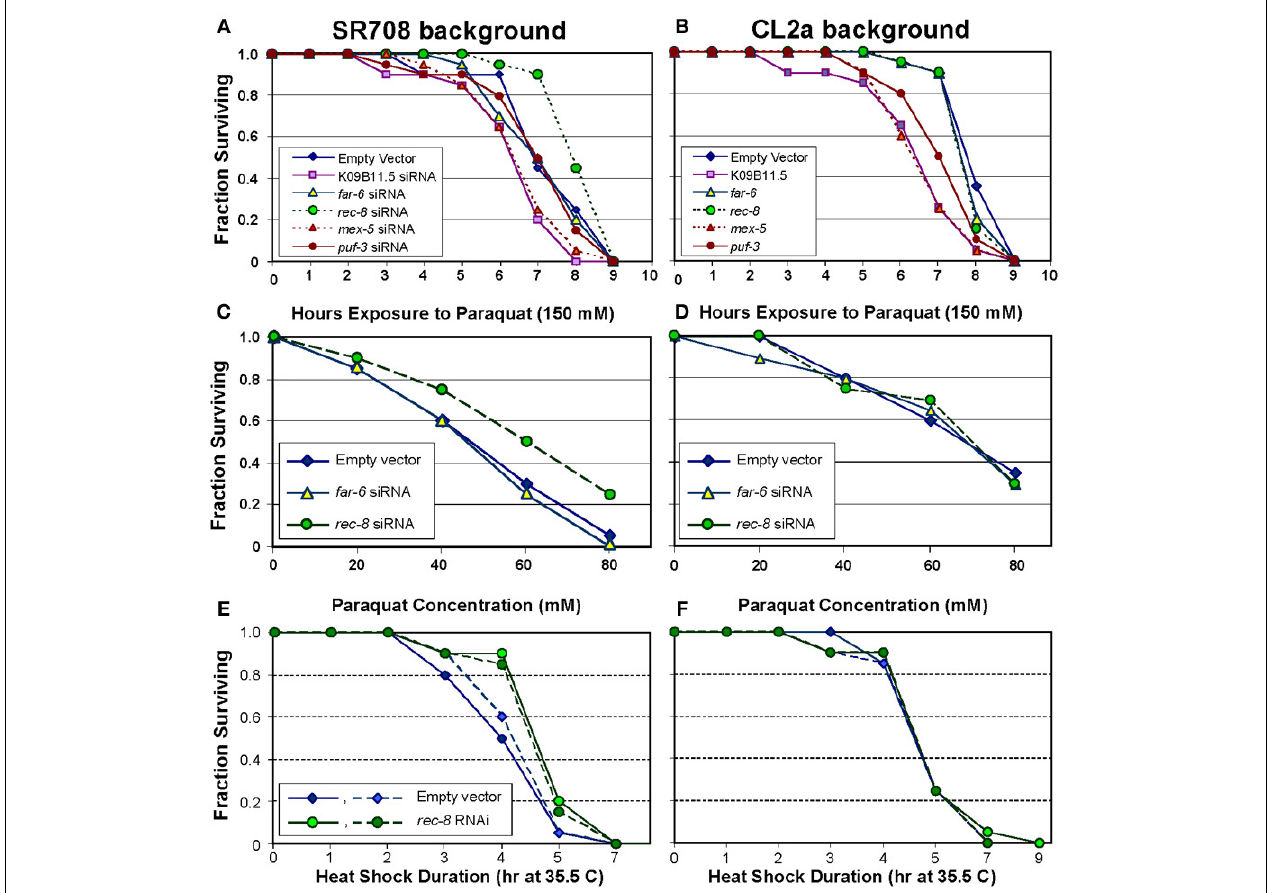
FIGURE 2 | Rec-8 knockdown improves resistance to oxidative and thermal stresses, dependent on the lsq4 –region background. Groups of 30 worms were fed on bacteria induced to express the indicated dsRNA (or empty expression vector) for 3 days from the L4/adult molt. They were then transferred to medium containing paraquat, and their subsequent survival monitored (see Methods). Of the indicated genes targeted by dsRNAs, only K09B11.5 had been found to be expressed at higher levels in CL2a, the longer-lived strain, and thus predicted to possibly reduce CL2a survival; the other 4 genes were expressed at higher levels in SR708, and thus were predicted to extend survival of treated SR708, if causal to the QTL effect on